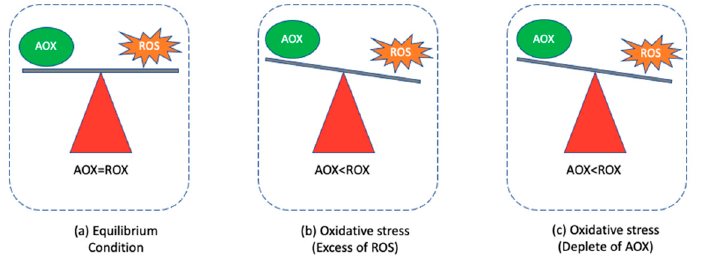
Figure 1. Equilibrium of ROS and antioxidants (AOX) ( a ) and their disequilibrium causing oxidative stress, either by an excess of ROS ( b ) or a deficiency of AOX ( c ).